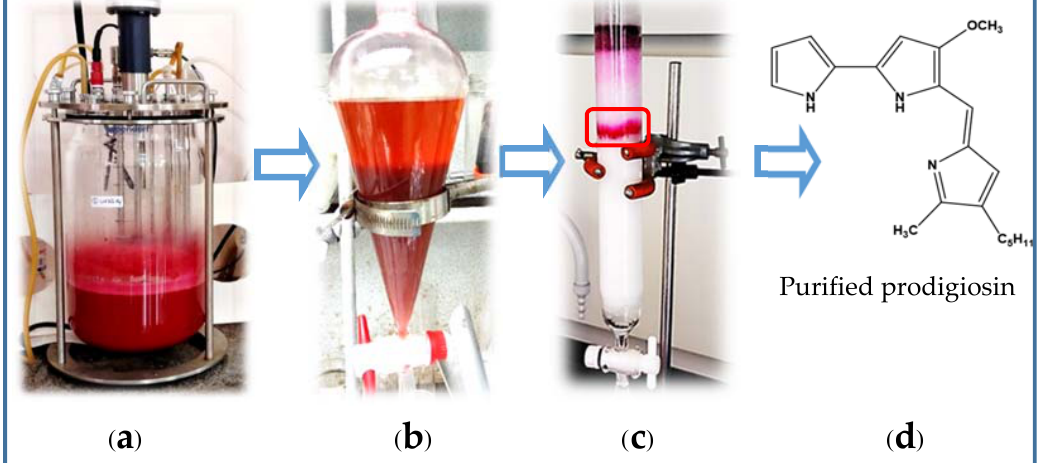
Figure 3. The purification of PG. The red pigment compound in the culture broth after 8 h of fermentation in a 12 L-bioreactor system ( a ) was first extracted by ethyl acetate ( b ) and was then isolated to pure compound in a silica gel separation column ( c ). The chemical structure of PG ( d ).